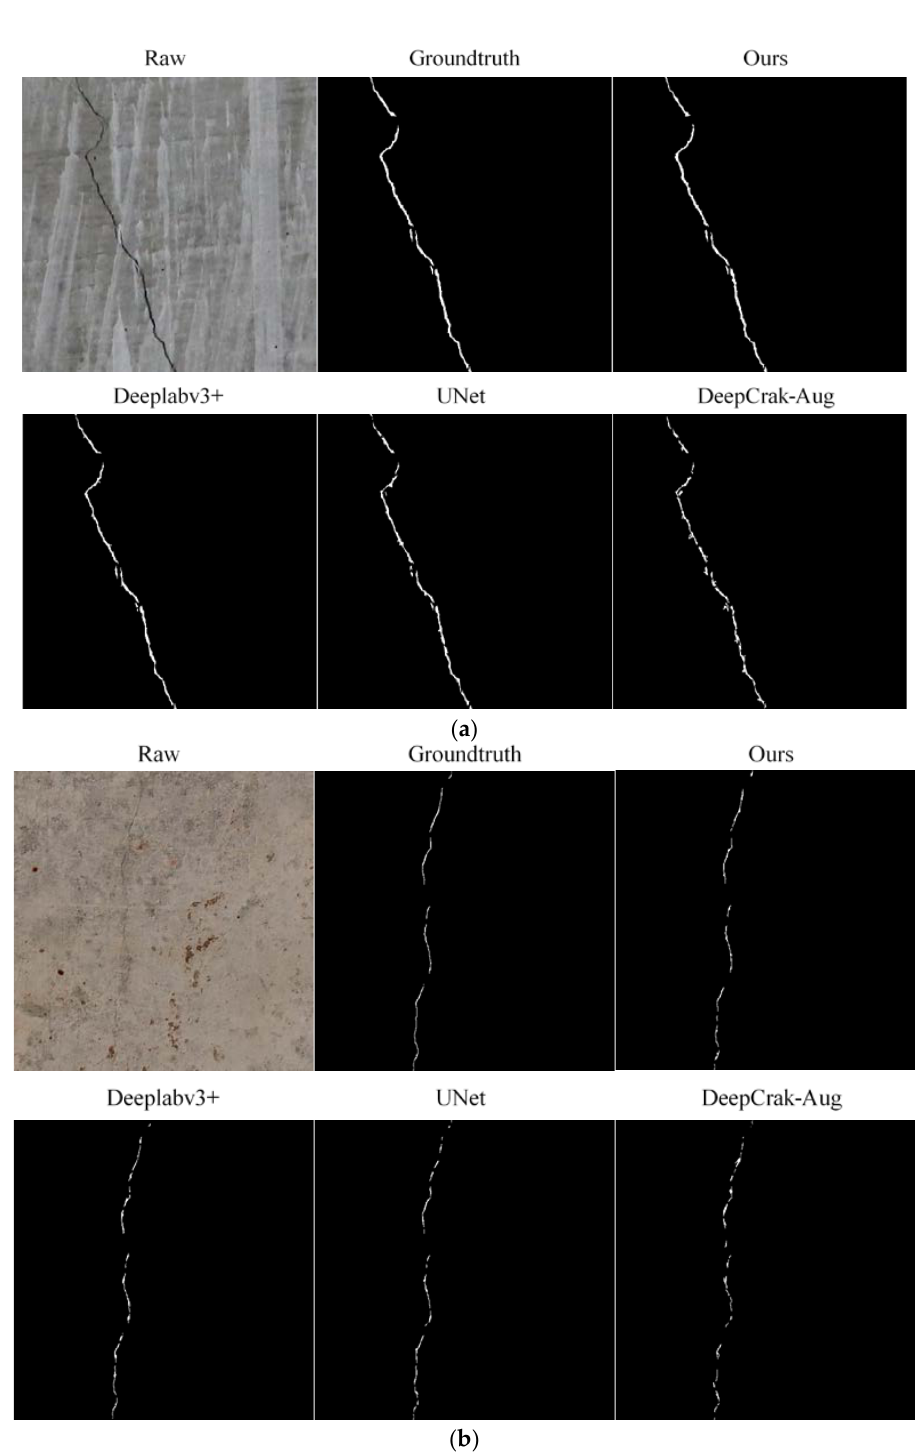
Figure 11. Segmentation results comparison of multiple models. Subfigure ( a , b ) are two randomly selected crack